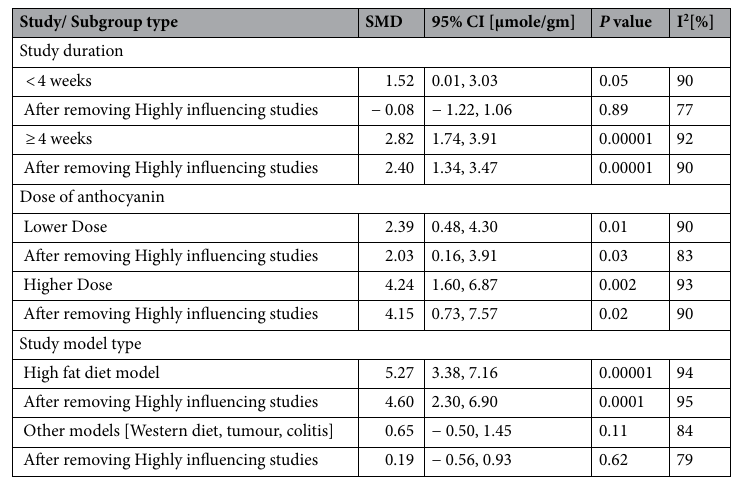
Table 7. All-inclusive, high-influencer subtracted and sub-group [intervention duration, dose, and animal model type] analysis to understand the effects of anthocyanins on the propionic acid. Pooled effect sizes and 95% CI were determined using Random effects model. SMD Standardised mean difference, I 2 = Heterogeneity.